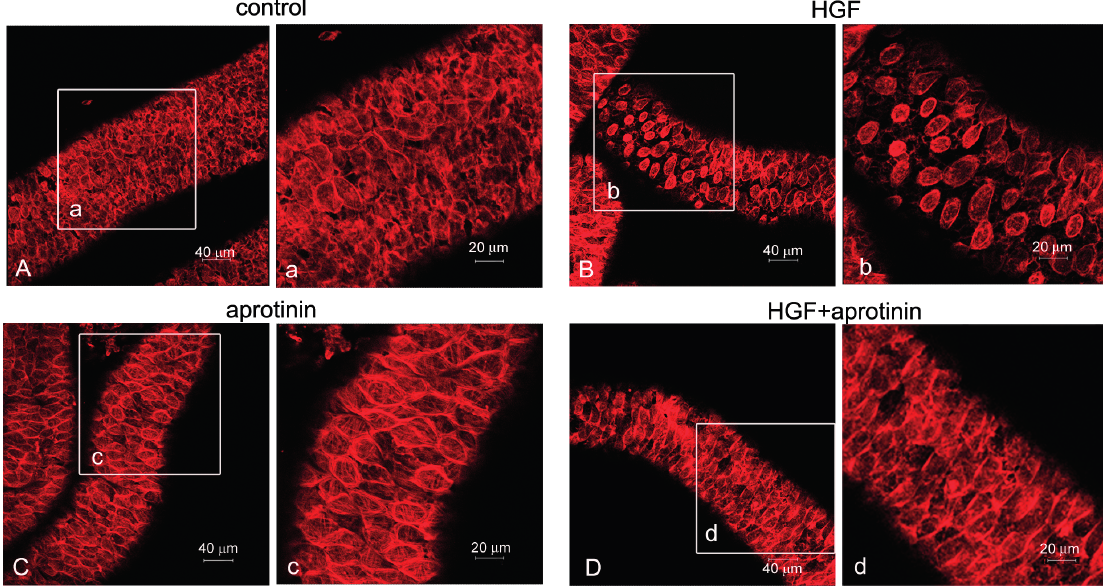
Figure 2. Confocal analysis of F-actin cytoskeletal modifications in cultured prepubertal